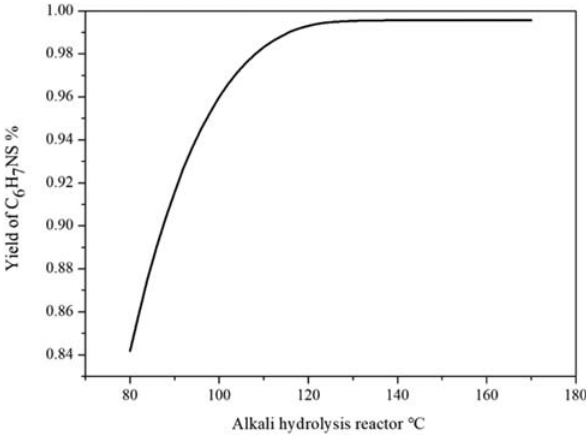
Figure 6: Relationship between the temperature of the alkali hydrolysis reactor and the yield of C 6 H 7 NS.